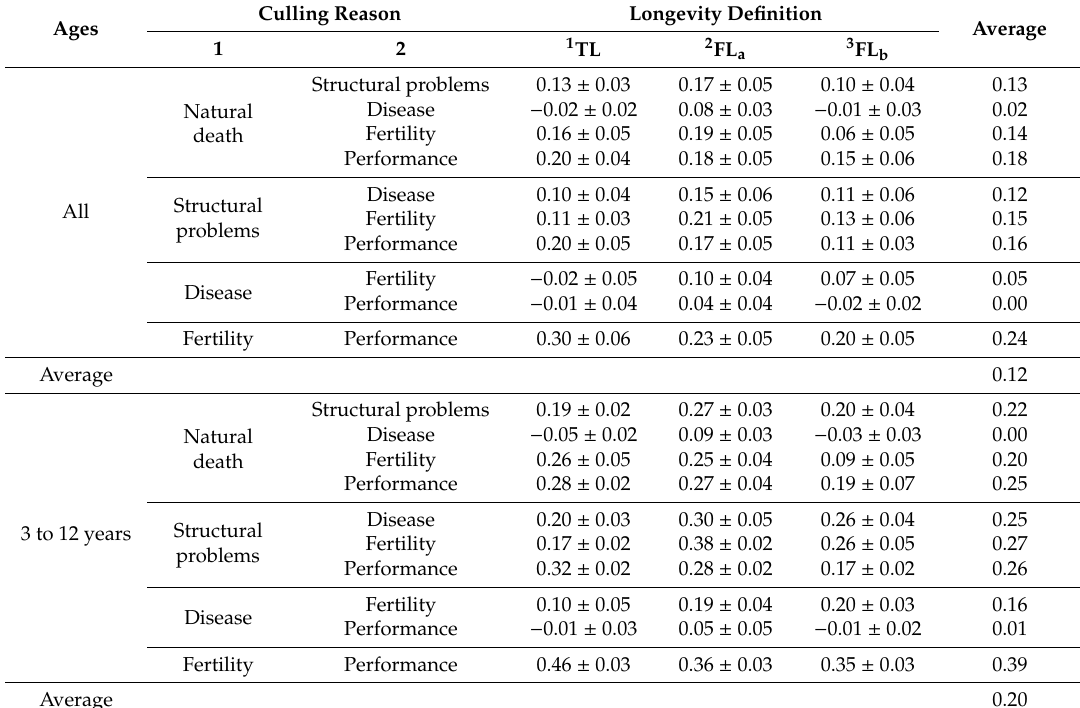
Table 5. Average ( ± SE) genetic correlations estimated between the di ff erent culling reasons considering all ages (i.e., from 2 to 15 years) and ages between 3 and 12 years-old, for all longevity definitions.